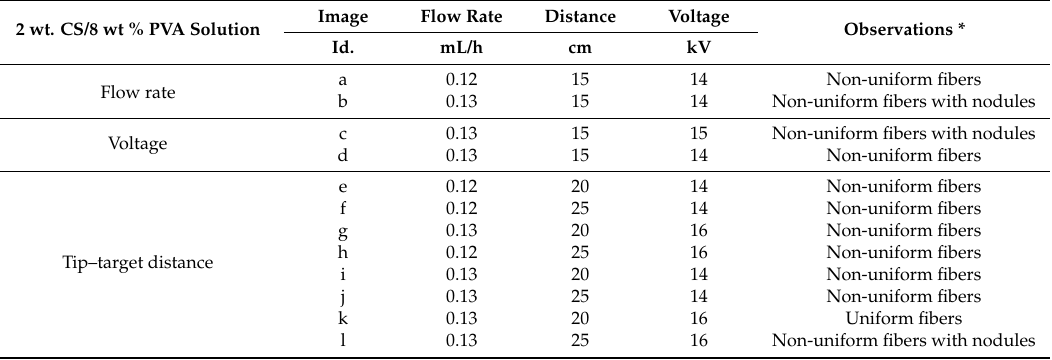
Table 1. Experimentally evaluated parameters using a 2 wt % CS/8 wt % PVA solution. 2 wt. CS/8 wt % PVA